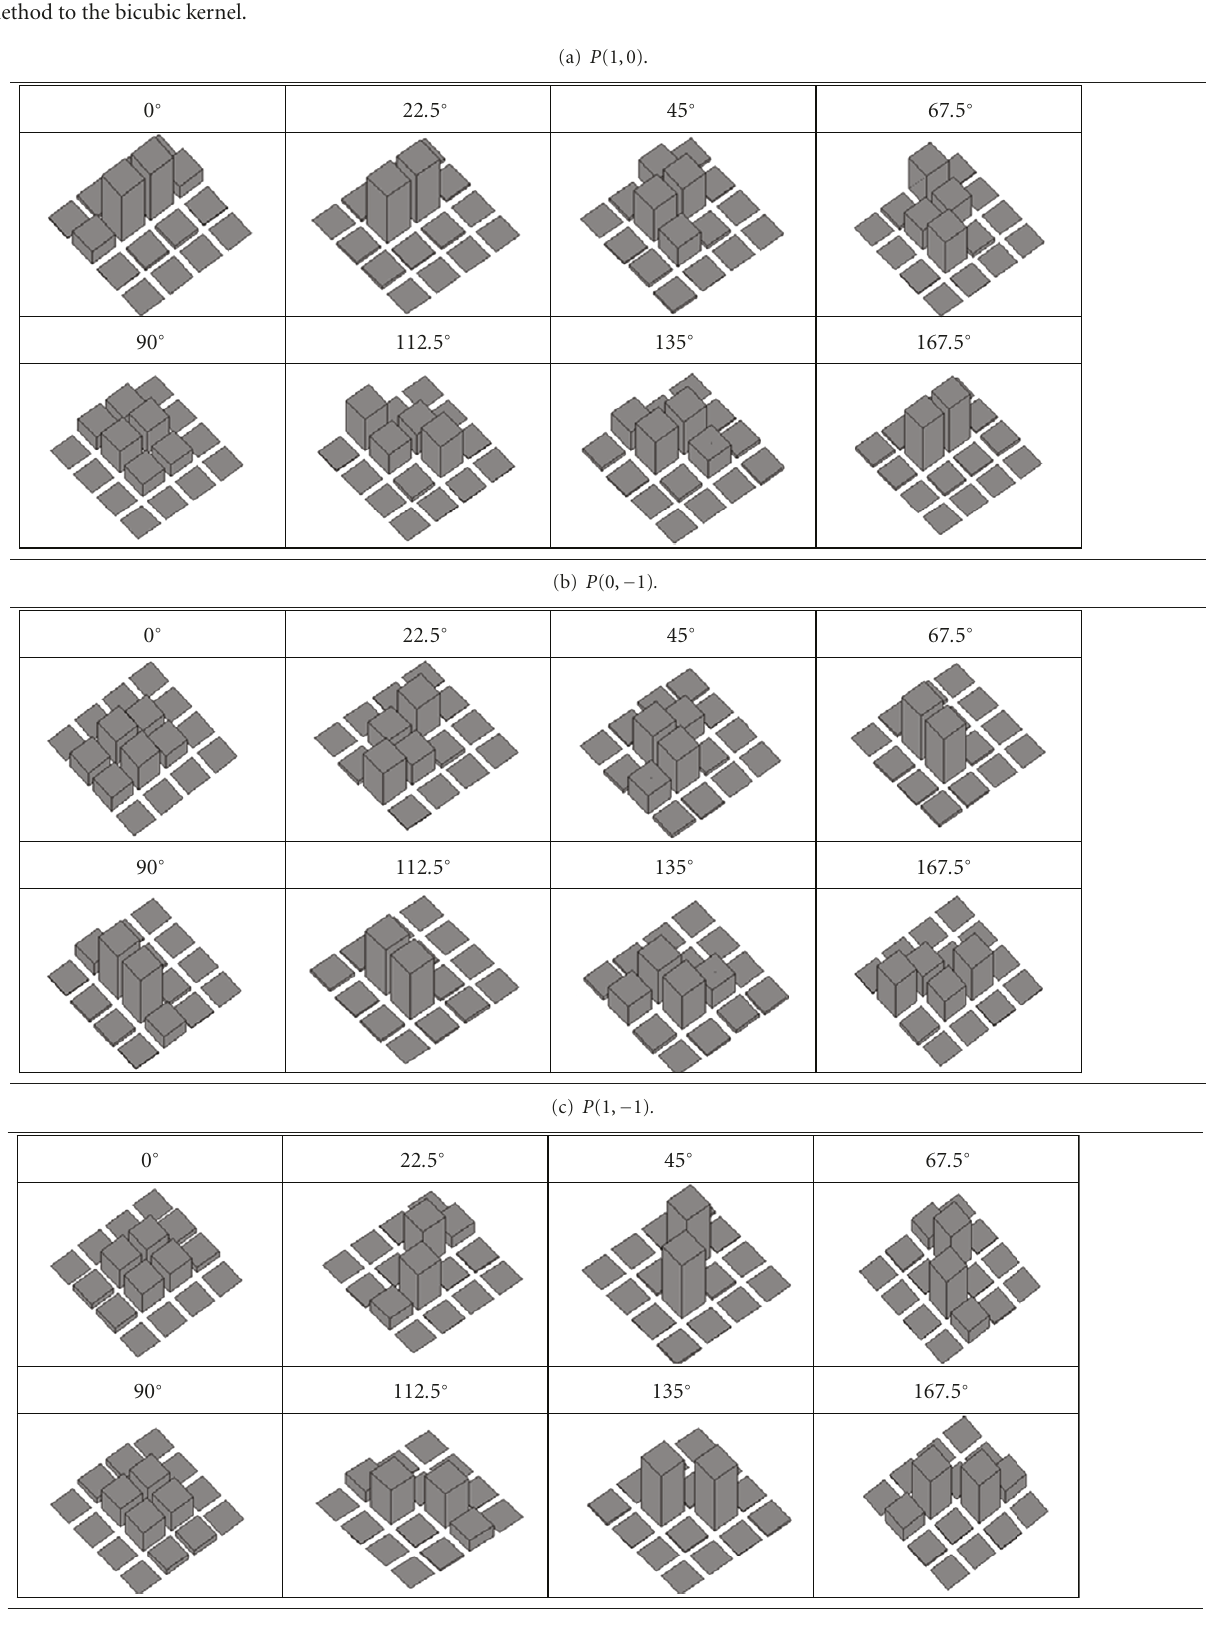
Table 2: The weighting matrices for image interpolation obtained by applying the proposed coordinate rotation and kernel stretching method to the bicubic